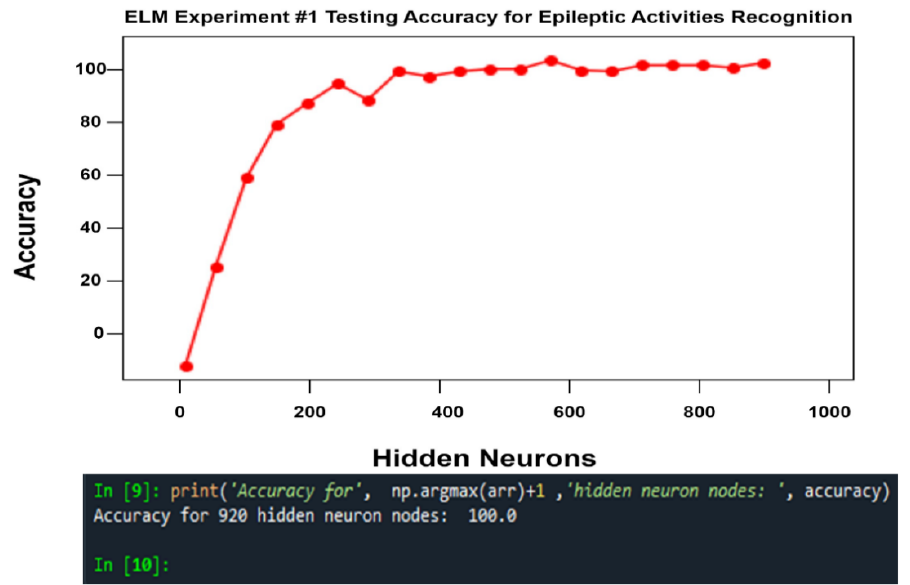
Figure 5. ELM Model Accuracy of Experiment #1.